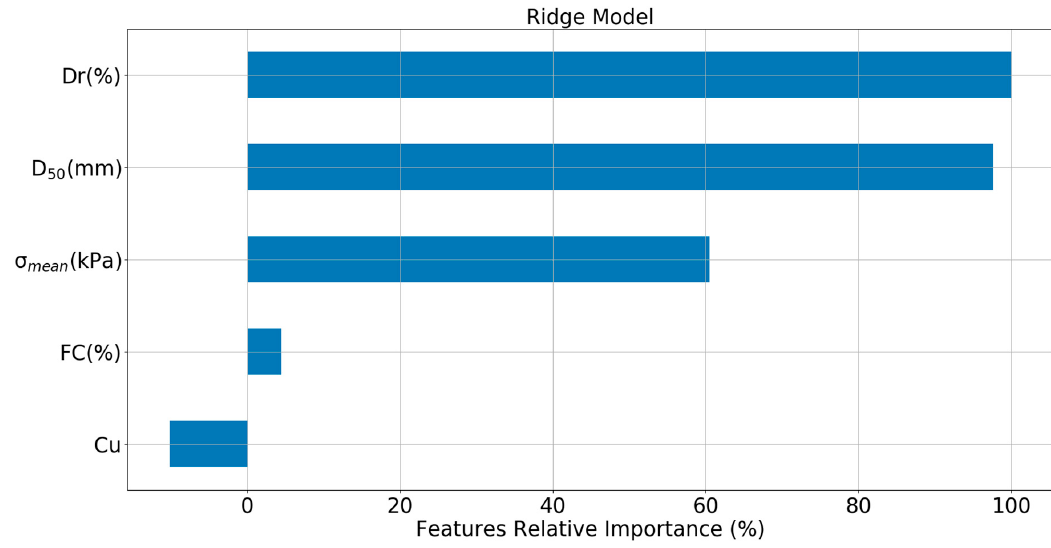
Figure 11. Relative importance of the input variables for the developed Ridge model.